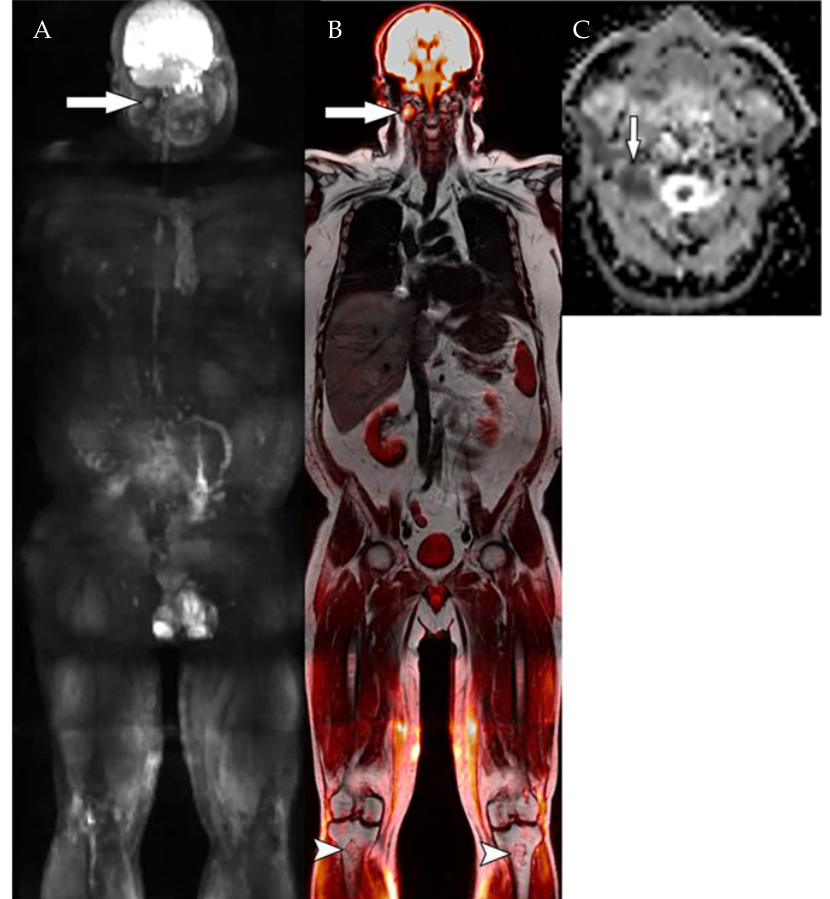
Figure 1. A 45-year-old man with hyposecretory IgG kappa multiple myeloma (MM) and a history of autologous stem cell transplantation 3 years before imaging. Patient had received radiation therapy to L1 vertebral body 2 years ago, and has been on maintenance therapy (carfilzomob, pomalidomide, and dexamethasone) for 6 months. WB-MRI images failed to demonstrate any osseous lesion, but showed a 12 mm extramedullary lesion deep to right parotid gland (arrow) on coronal high b-value (b = 800) DWI MIP image ( A ). Fused coronal DWI MIP and T1-weighted Dixon image ( B ) confirms the finding (arrow). Axial ADC map ( C ) confirms diffusion restriction (mean value of 0.8 ( × 10 − 3 mm 2 /s). Note areas of marrow infarction at bilateral proximal tibial metaphysis (arrowheads, ( B )).